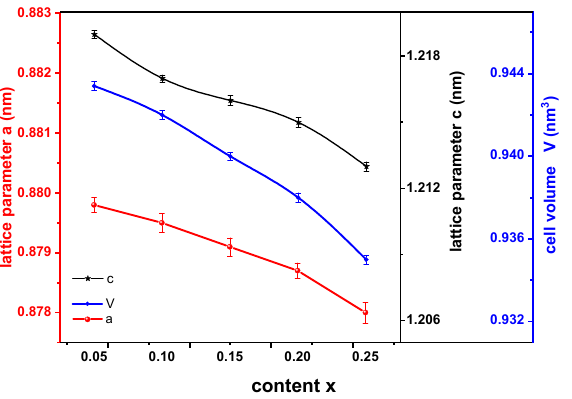
Figure 2. Lattice parameters and cell volumes of (NdCeY) 2 Fe 14 B phase in (Nd 1-2x Ce x Y x ) 14.5 Fe 79.3 B 6.2 alloys annealed at 1173 K for 360 h. Figure 3 is the microstructure image of (Nd 1-2x Ce x Y x ) 14.5 Fe 79.3 B 6.2 annealed alloys. As can be seen, the microstructure characteristics of the annealed alloys show (NdCeY) 2 Fe 14 B phase (gray area) and rich-RE ( α -Nd) phase (white area), while the α -Fe phase was not observed, which is in good agreement with the XRD results. It was found that the volume fraction of the rich-RE ( α -Nd) phase (white area) in annealed alloys increases gradually with the increase of Ce and Y substitutions. Figure 4 is the XRD patterns of (Nd 1-2x Ce x Y x ) 14.5 Fe 79.3 B 6.2 melt-spun ribbons.